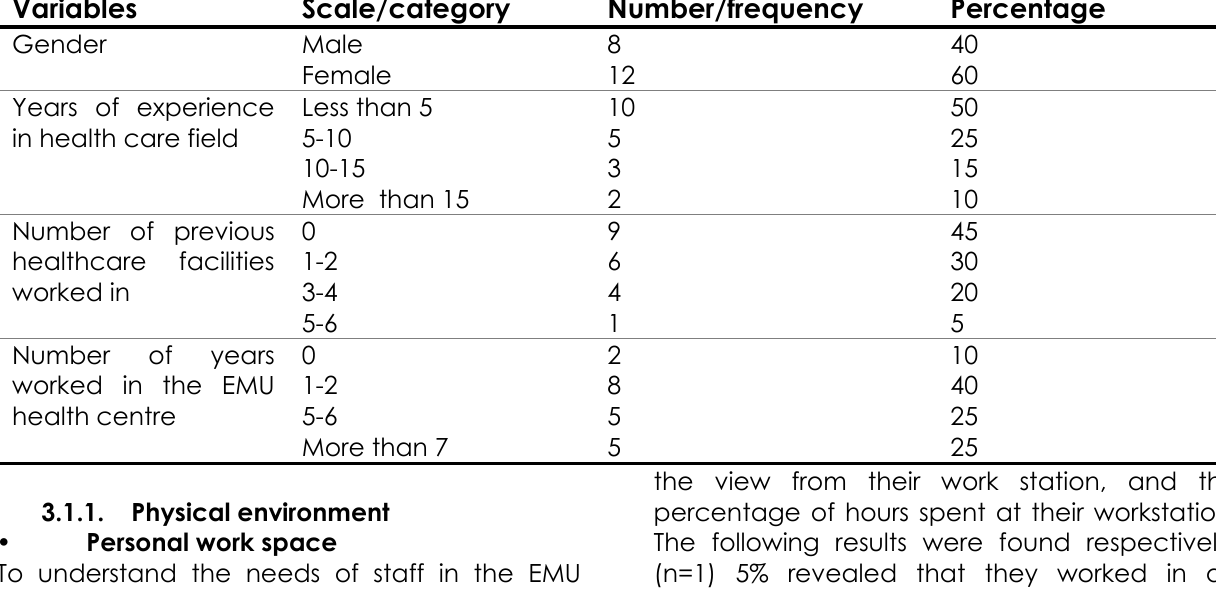
Table 1. Demographic information of